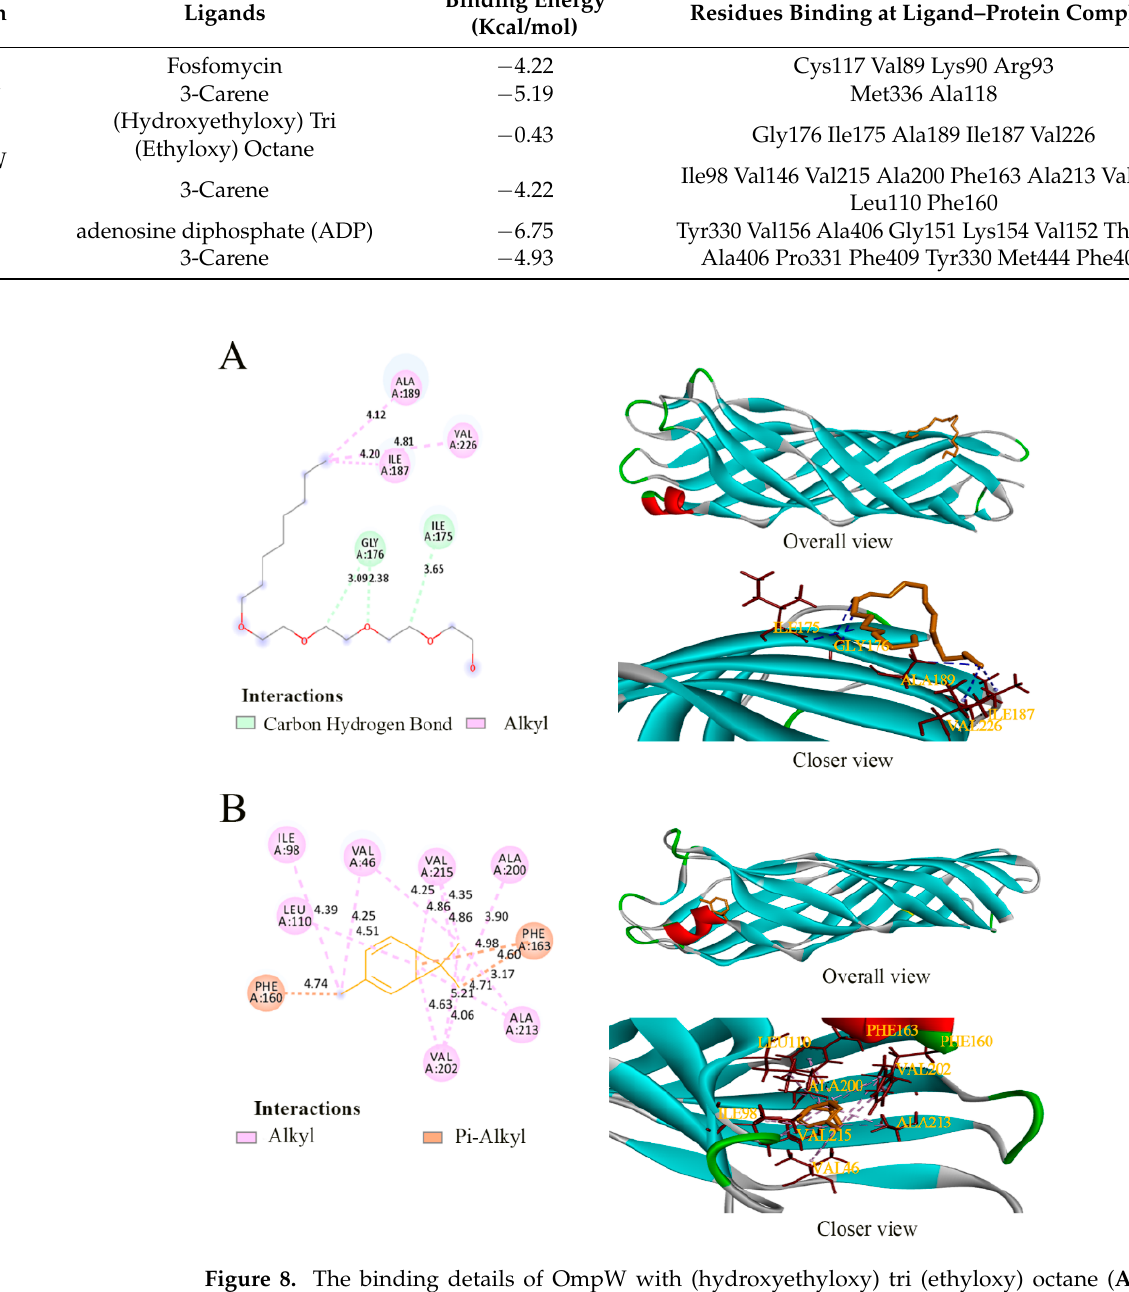
Figure 9. The binding details of AtpD with adenosine diphosphate (ADP) ( A ) and 3-carene ( B ).